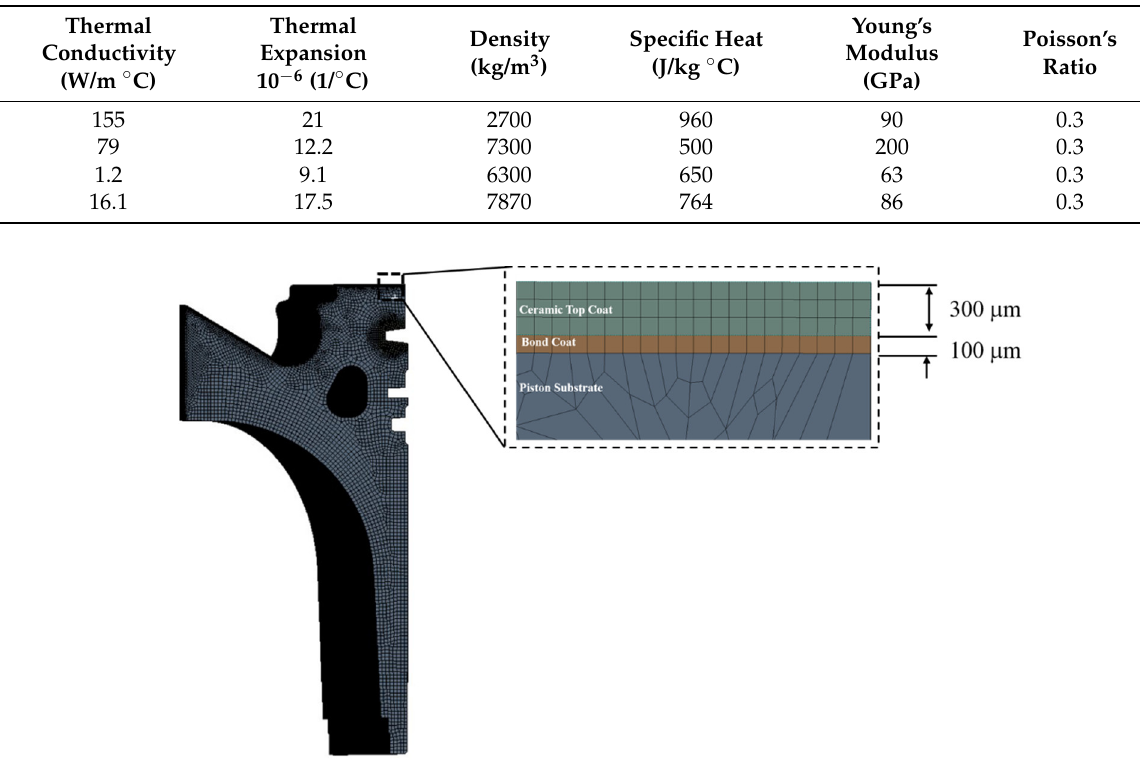
Figure 7. The one-eighth piston model and thickness of the thermal-barrier coating.